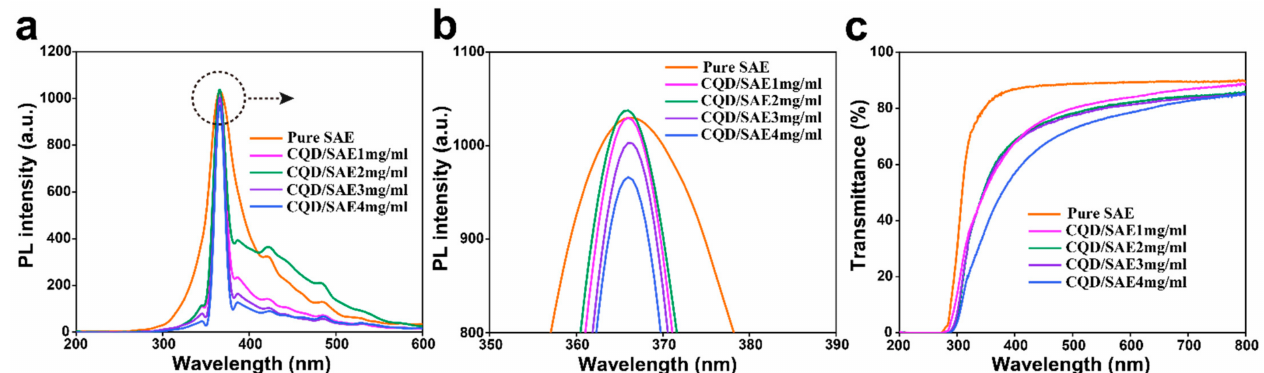
Figure 2. ( a ) The photoluminescence intensity of pure SAE and CQD/SAE coating films. ( b ) The detailed view of PL intensity. ( c ) Transmittance spectra of pure SAE and CQD/SAE coating